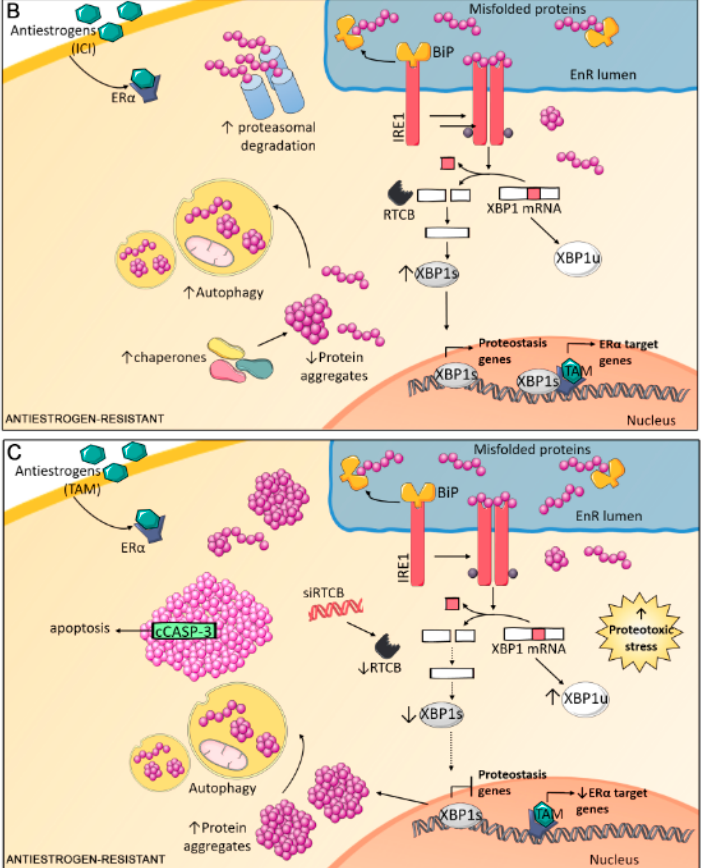
Figure 6. Schematic representation of the findings presented in this work in the context of previously described mechanisms guiding endocrine resistance. ( A ) In antiestrogen-sensitive cells, treatment with antiestrogens induces ER α proteasomal degradation (ICI) or inhibits the transcription of ER α target genes (TAM); consequently, proliferation and survival signaling is halted. Additionally, an- tiestrogen therapy increases oxidative and metabolic stress, which hinders correct protein folding to increase their aggregation. The results presented herein show that the PQC network (autophagy, UPR and proteasome) may be rapidly saturated leading to aggresome accumulation. Aggresomes contain essential proteins needed to overcome proteotoxic stress (i.e., RTCB, chaperones and PQC proteins), reducing their function. Aggregated RTCB cannot complete XBP1 splicing, XBP1 levels drop and, consequently, the activation of proteostasis genes under XBP1 regulation, like BiP, becomes compromised. Altogether, these events may generate a positive feedback loop increasing the accumu- lation of aggresomes which, in turn, potentiates the proteome instability and contributes to impair stress responses. Activation of pro-apoptotic pathways with co-localization of cleaved caspase 3 (cCASP-3) in aggresomes ultimately results in cellular death. ( B ) Antiestrogen-resistant cells have a higher autophagic and proteasomal degradation capacity, which, coupled with induced expression of XBP1s and transactivation of its target genes (i.e., BiP, chaperones, ERAD response) allows resistant cells to cope with protein misfolding and aggregation, keeping aggresome levels low. In addition, co-activation of ER α by XBP1s is possibly maintained, resulting in increased proliferation and treat- ment with antiestrogens do not compromise survival signaling. ( C ) RTCB knock-down in resistant cells treated with antiestrogens, results in impaired XBP1 expression which is sufficient to promote aggresome accumulation. Impaired transcription of proteostasis genes by XBP1s possibly contributes to saturate the PQC network. Intolerable proteome instability and consequent proteotoxic stress may activate pro-apoptotic pathways resulting in cellular death as observed by cCASP3